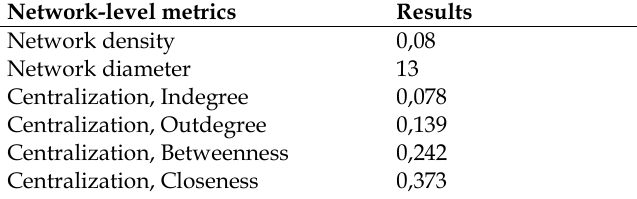
Table 5. The results of the network-level